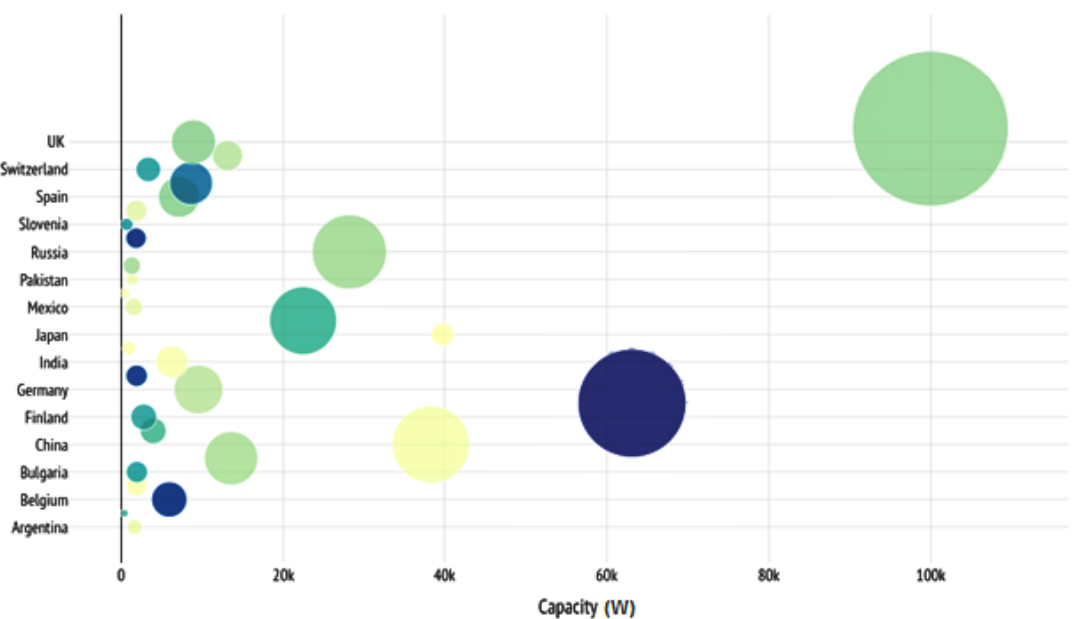
Figure 1. Worldwide nuclear energy production via number of reactors and overall capacity. Adapted from [12].